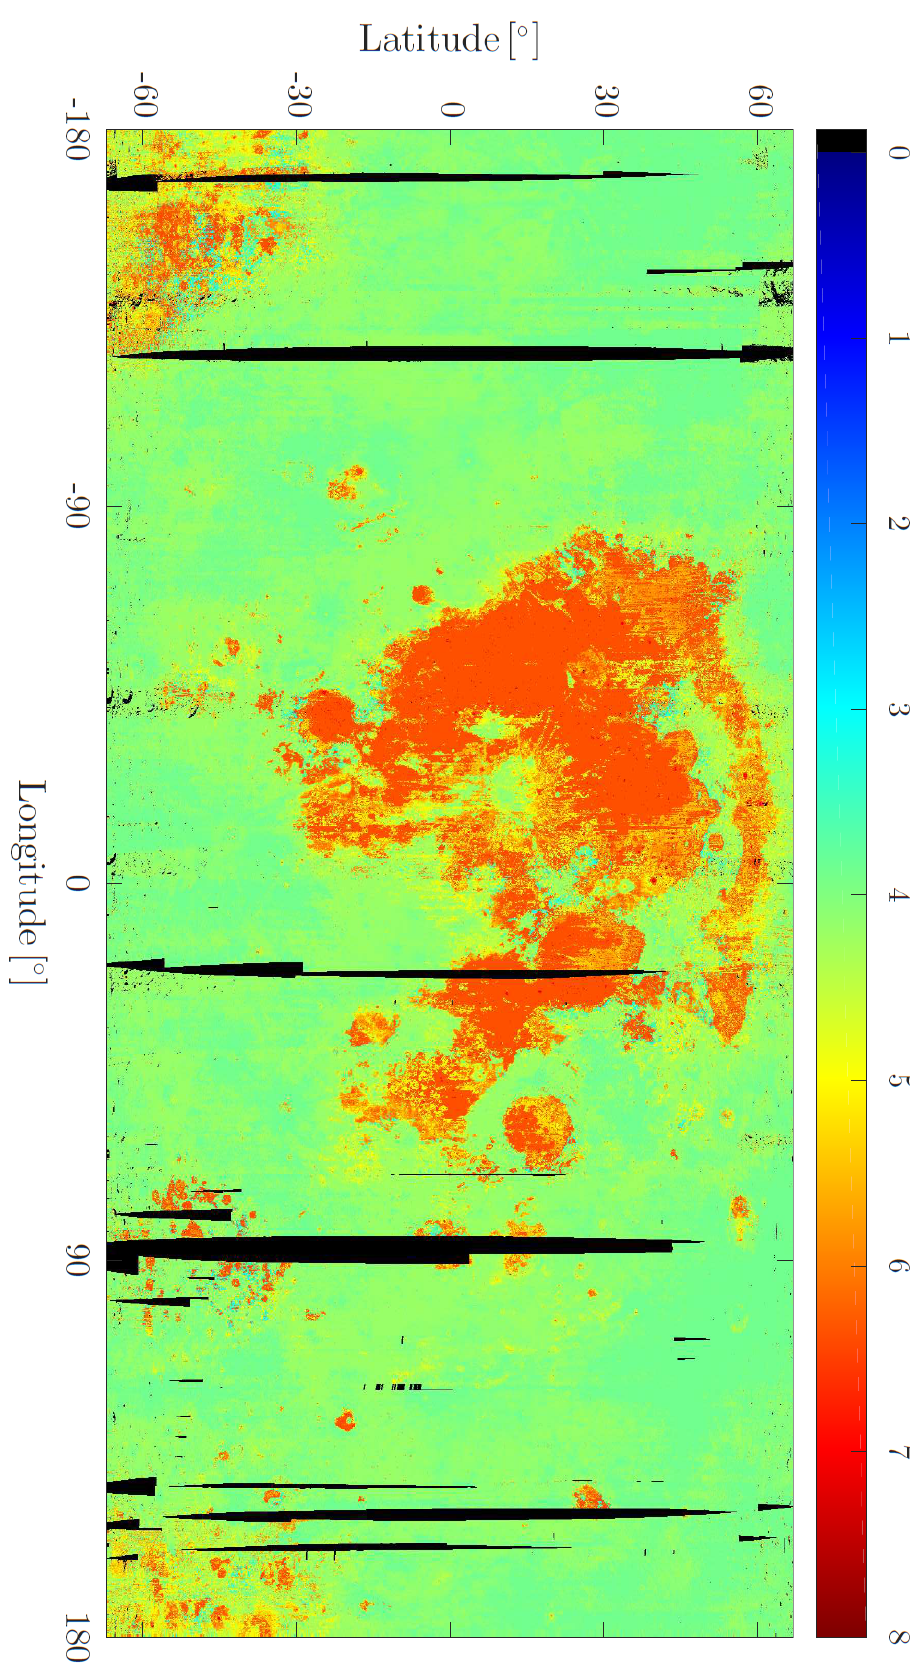
Figure 3. Map of the fractional abundance of olivine (in percent). Black pixels denote missing